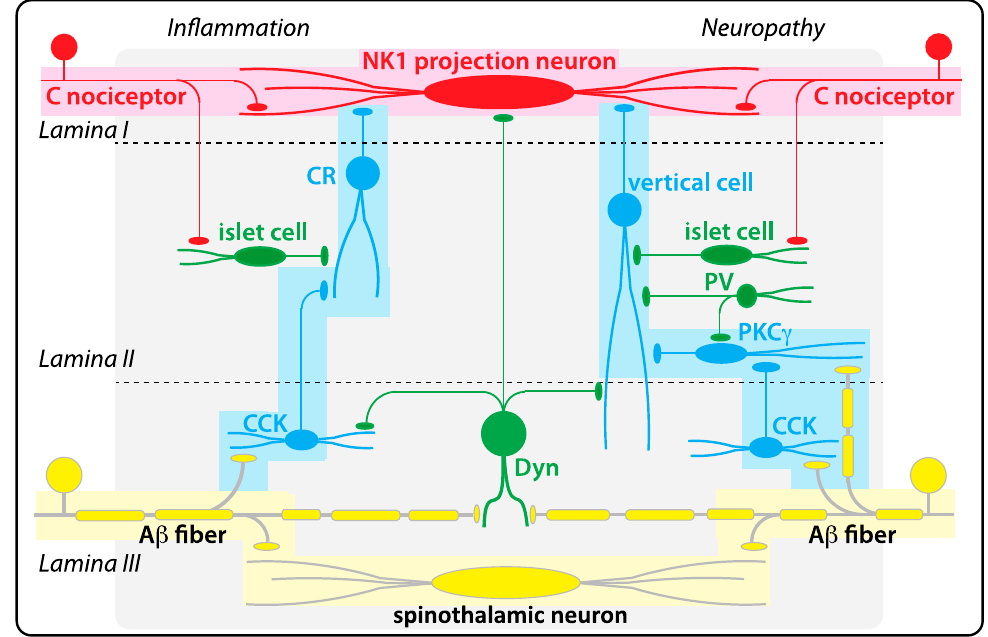
Figure 3. Simplified model of the dorsal horn neuronal circuits of allodynia recruited during inflammation and neuropathy. Under healthy conditions, relay pathways for noxious stimuli (red) and innocuous tactile stimuli (yellow) are strictly separated. Noxious stimuli enter the superficial layers of the dorsal horn via nociceptive C fibers, which activate neurokinin 1 receptor positive (NK1) projection neurons located in lamina I. Tactile input is conveyed by myelinated A β fibers, which activate spinothalamic projection neurons in the deep dorsal horn. Polysynaptic connections between both modalities are preexisting (blue) but normally silenced by glycinergic and GABAergic input. In inflammation (left), the pathway starts with cholecystokinin (CCK) positive excitatory interneurons that are activated by A β fibers and project to calretinin positive neurons (CR), which then excite NK1 projection neurons in lamina I. In neuropathy, the pathway also begins with cholecystokinin (CCK) positive interneurons, which activate PKC γ positive interneurons. The PKC γ interneurons the project to so-called vertical cells, which connect to lamina I NK1 projection neurons. PKC γ positive neurons can also be directly activated by A β fiber input. Several types of inhibitory interneurons (green) silence these polysynaptic pathways, among them are parvalbumin positive (PV) neurons, dynorphin positive interneurons (Dyn), and so-called islet cells. Dyn and PV neurons evoke postsynaptic responses with a strong glycinergic component. About half of the more superficially located islet cells release glycine in addition to GABA. Many of these inhibitory interneurons are activated by input from nociceptors or non-nociceptive A β fibers and thereby provide feed-forward inhibition. Schemes are based on